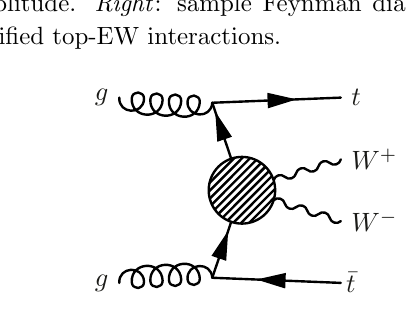
(cid:0) process and its embedding